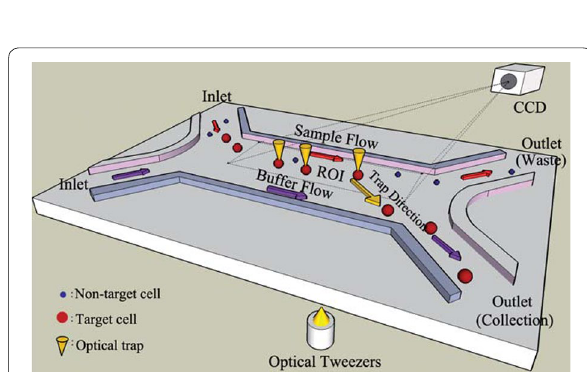
Fig. 8 A schematic diagram of the device developed by Wang et al. [24]. The sample and buffer are introduced into the channel from the two inlets located on the left. As the cells pass through the region of interest (ROI) they are captured by the CCD camera. The images are processed in real-time to locate cells of interest. A control signal is then generated positioning the optical trap on the cell of interest. After capture it is moved to the desired